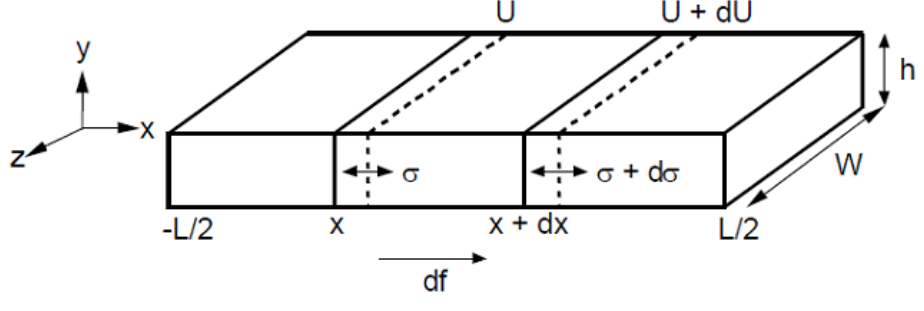
Figure 2. Orientation of forces acting on a magnetoelastic sensor used in deriving the equation of motion. Reprinted with permission from